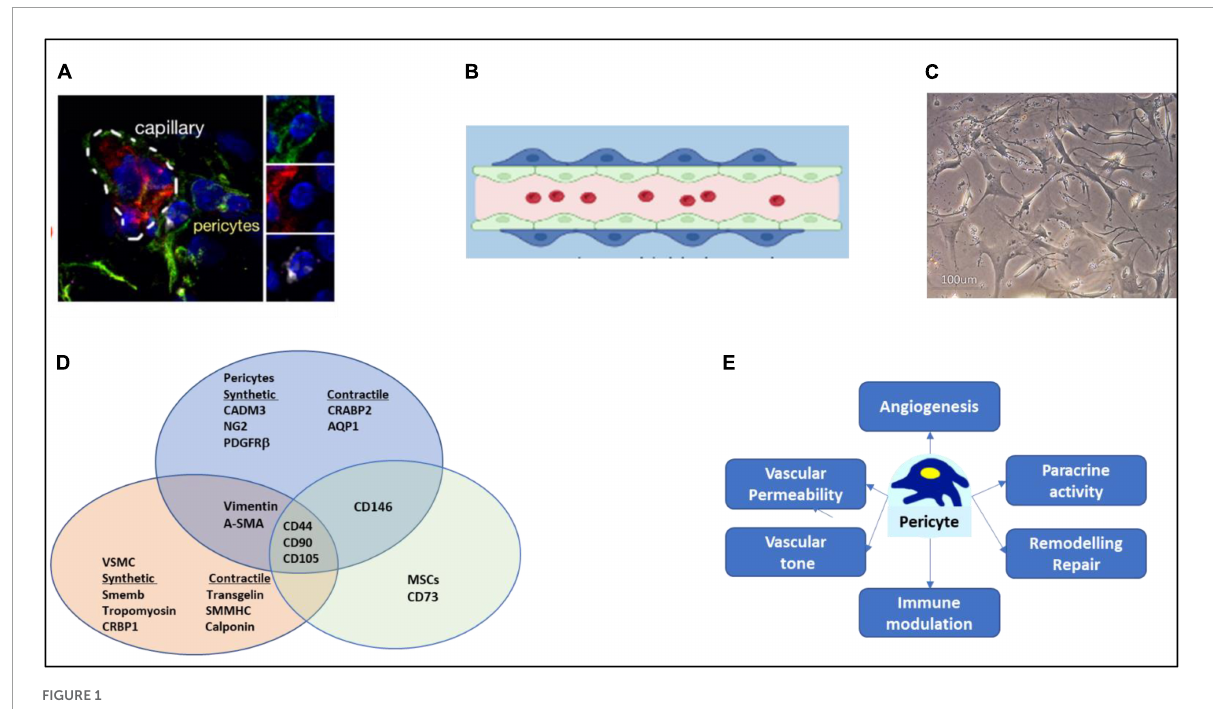
FIGURE1 Characteristics of pericytes. (A) Immunofluorescence microscopy image of NG2 positive (green) pericytes, with endothelial cells labeled in red and nuclei in blue. (B) Cartoon of pericyte around a capillary lined internally by endothelial cells. (C) Aspect of pericytes in culture. (D) Overlapping of antigens with other mesenchymal cells. For clarity, refer to text for the overlapping with perivascular fibroblasts. (E) Key pericyte functions. Image in (A) has been reproduced with permission from the original article in Avolio et al.